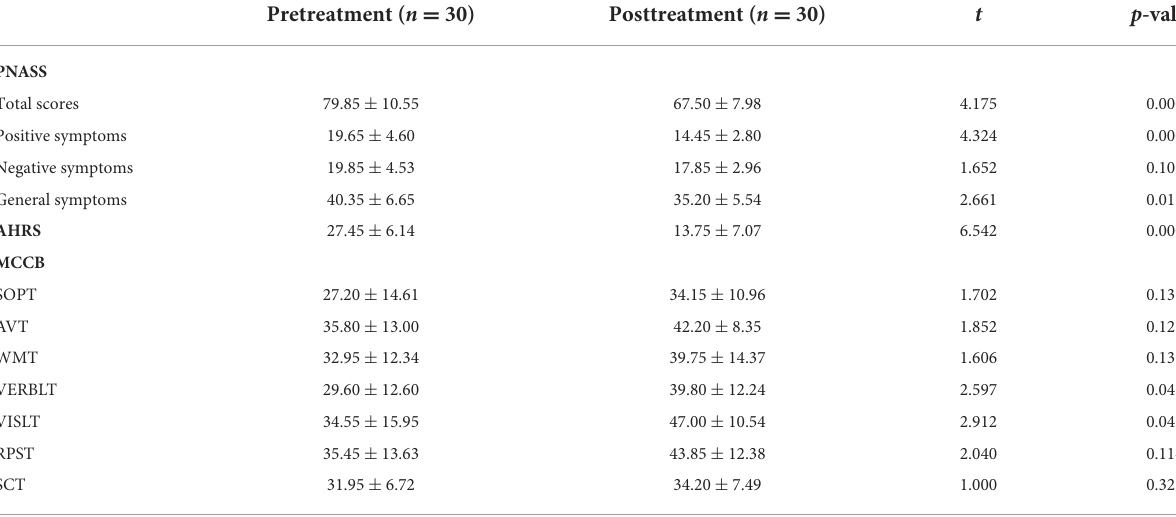
TABLE 2 Comparisons of clinical responses between patients before and after